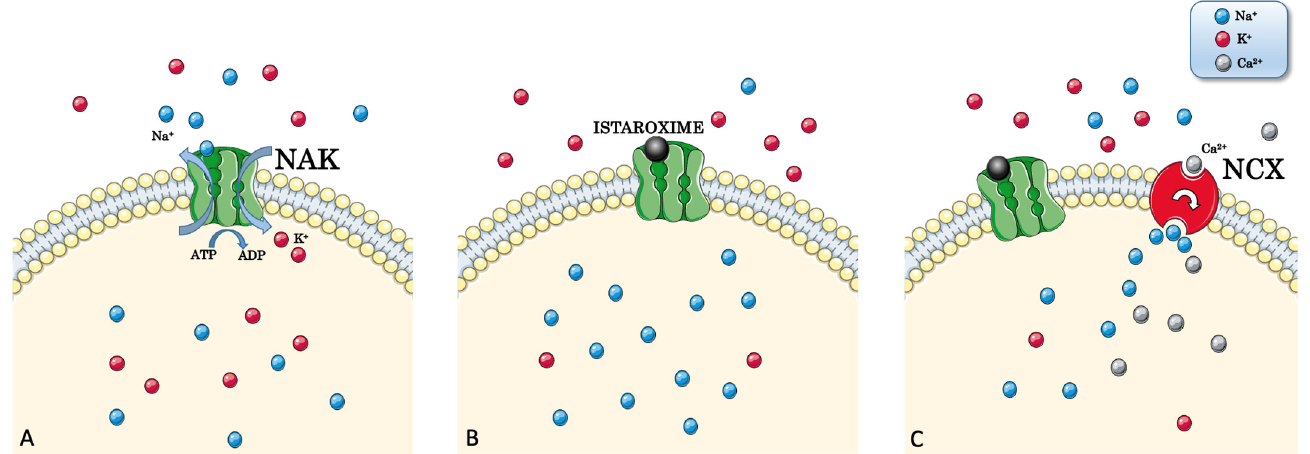
Figure 1. Istaroxime inhibits the Na + /K + -ATPase (NAK) pump. ( A ) NAK actively transports three Na + -ions through the cell membrane outside the cytosol in exchange for two K + ions inside the cytoplasm. ( B ) Istaroxime inhibits NAK by binding it from the extracellular side with a consequent raise of [Na + ] in the intracellular side. ( C ) Increased [Na + ] leads to the activation of the Na + /Ca 2+ exchanger (NCX), which exchanges three Na + ions for one Ca 2+ ion, eventually increasing intracytoplasmatic [Ca 2+ ].